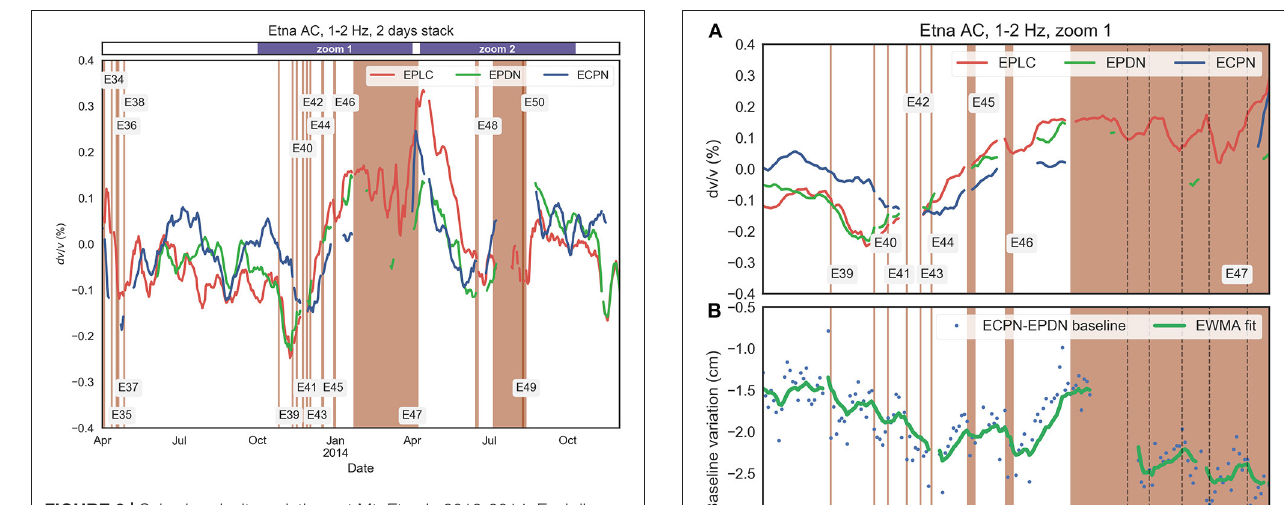
FIGURE 2 | Seismic velocity variations at Mt. Etna in 2013-2014. Each line corresponds to the average at each individual station (EPLC, ECPN, and EPDN) of the measured relative seismic velocity variation ( dv / v , in % ) for each component pair (e.g., ZZ, EE, NN). These dv / v are calculated using the autocorrelation in the 1–2Hz frequency band, and the cross-correlation functions are stacked linearly over 2 days. The median errors on the dv / v measurements are ∼ 0.03% for each station. The orange vertical lines and zones are labeled eruptive episodes described in Table 1 . The episodes were brief in duration and rather explosive (vertical lines) until E45, in the second half of December 2013, when the activity changed to more long-lived and effusive events that characterized 2014. The purple zones in the top subplot illustrate the timespans enlarged in Figures 3 , 4 .